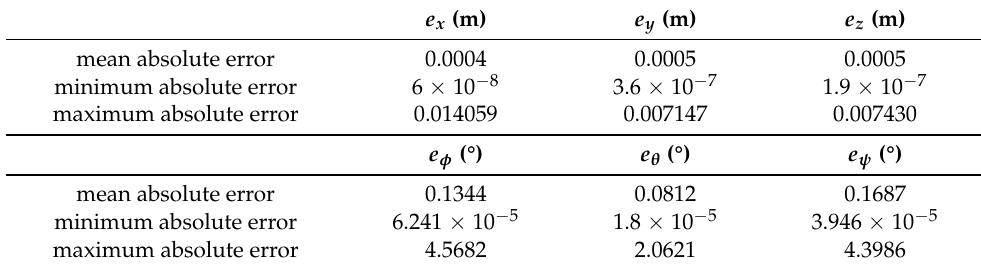
Figure 7. Absolute errors distribution of optimized solutions in each direction. Table 7. Error indicators for initial